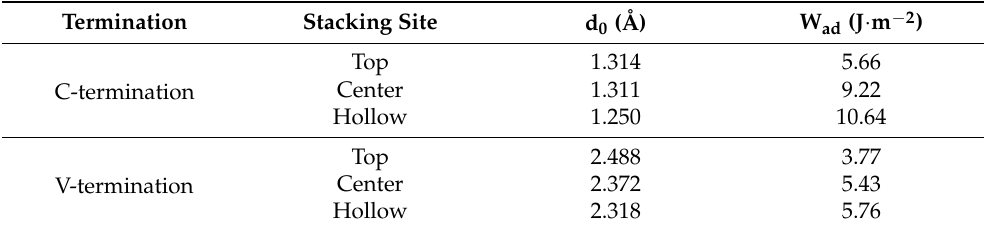
Figure 9. Interface geometries for C-terminated Mo(110)/VC(111) with three stacking sites: ( a ) top, ( b ) center, ( c ) hollow (The gray ball represents the V atom, the green ball represents the C atom, and the blue ball represents the Mo atom.). Table 3. Interfacial separation (d 0 ) and calculated work of adhesion (W ad ) of different interfacial geometries after full